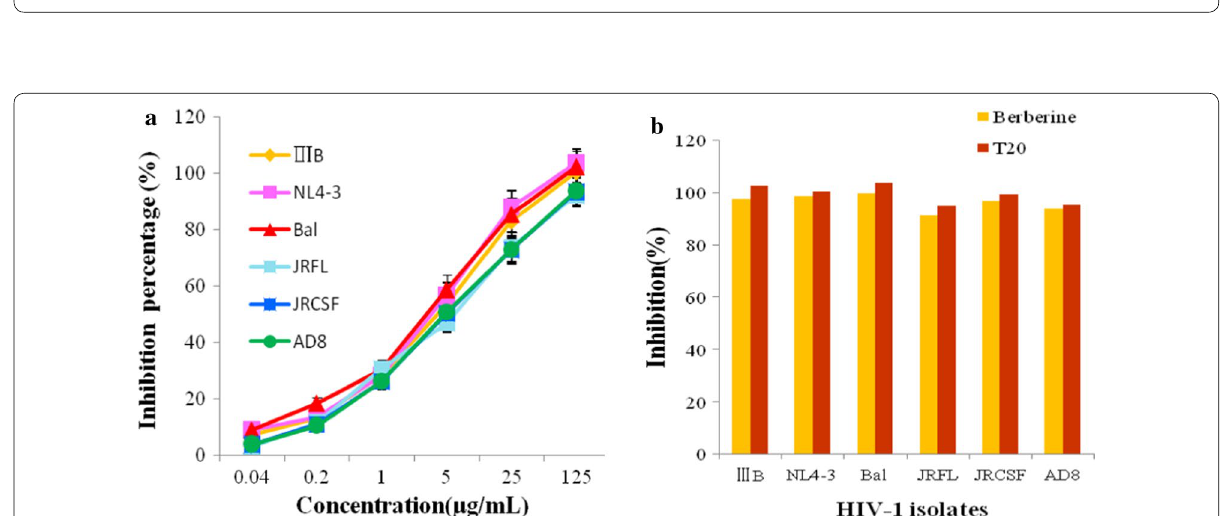
Fig. 6 Antiviral activities of berberine. a HIV-1 pseudotyped viruses were pre-inoculated with different concentrations of berberine and T20 for 30 min at 37 °C, and then the mixtures were added to target cells grown in each well of 96-well plates. Luminescence was measured and percentage inhibition was calculated. Each sample was tested in triplicate and the data were presented as mean Percentage inhibition of a panel of viruses was determined as described in the experimental procedures. The assay was performed in triplicate